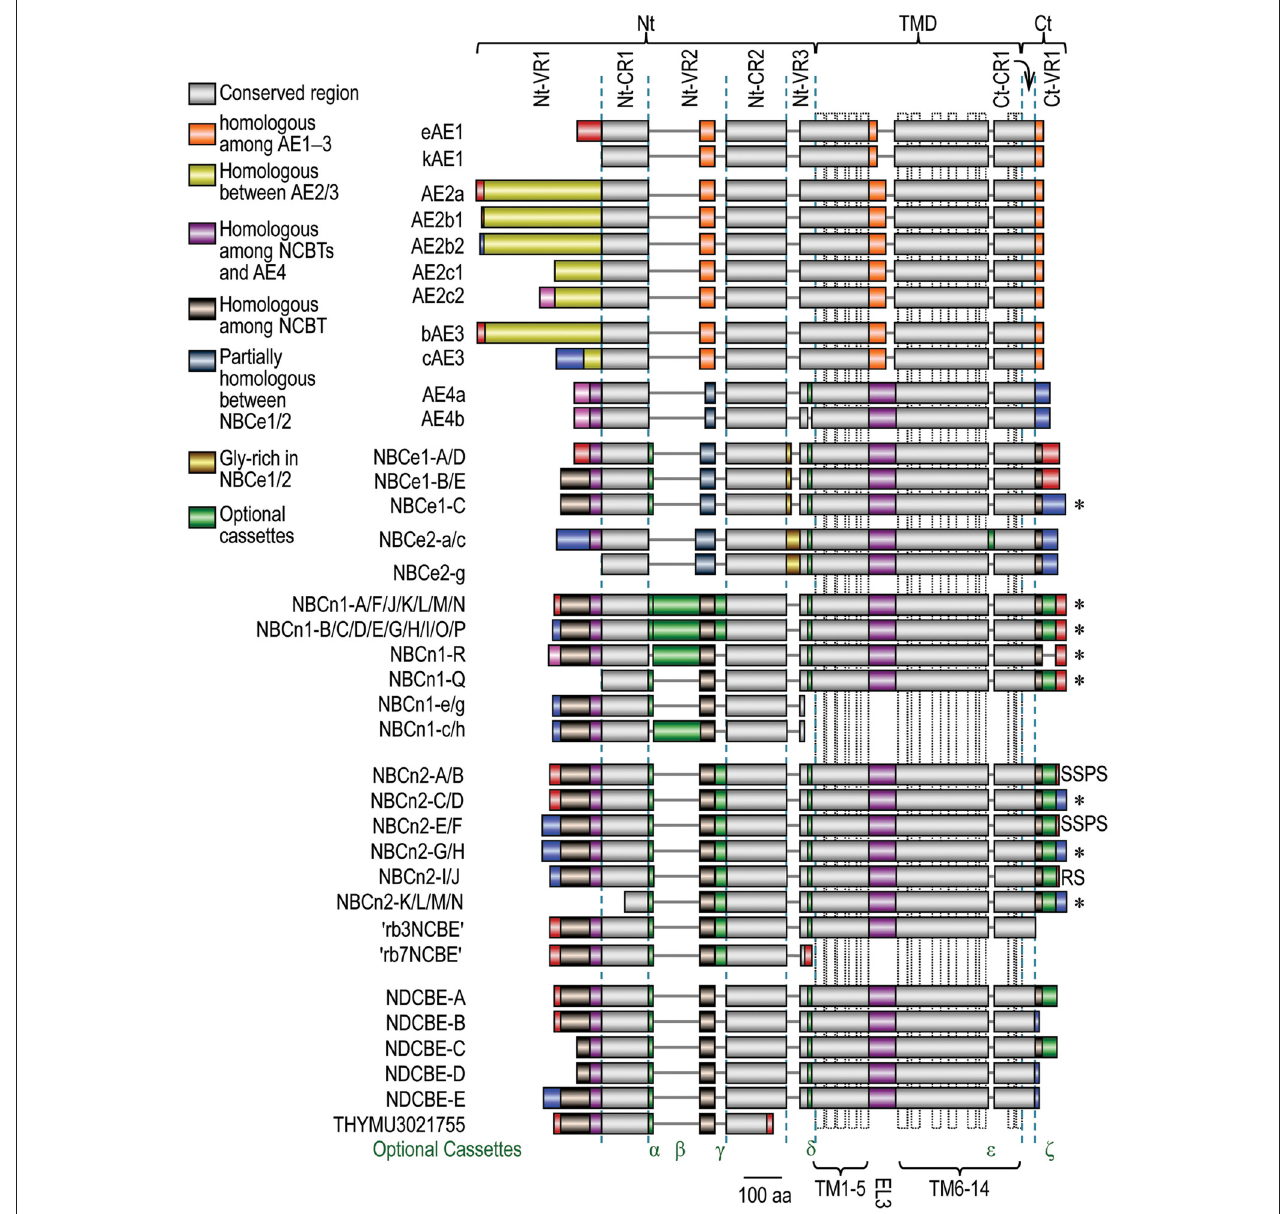
FIGURE 5 | Alignment of expression variants of SLC4 family HCO − 3 transporters. The diagram was based upon a sequence alignment with Clustal Omega from the European Bioinformatics Institute Details. Accession numbers for the SLC4 variants are available in Supplemental Table S1. The colors denoting homology among different SLC4 members are shown in the legend. The extreme Nt and Ct ends of different SLC4 members with identical color pattern do not denote homology unless specified elsewhere in the main text. The dotted vertical boxes in TMD indicate the putative transmembrane helices shown in model A in Figure 2 . * Proteins containing PDZ-binding motif at the Ct